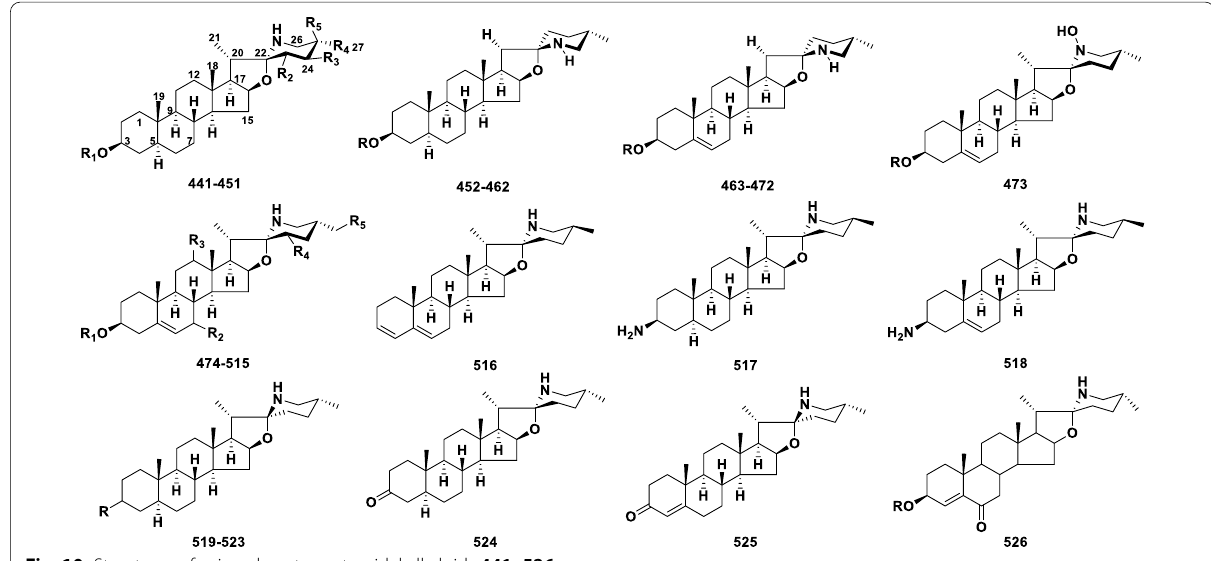
Fig. 10 Structures of spirosolane type steroidal alkaloids